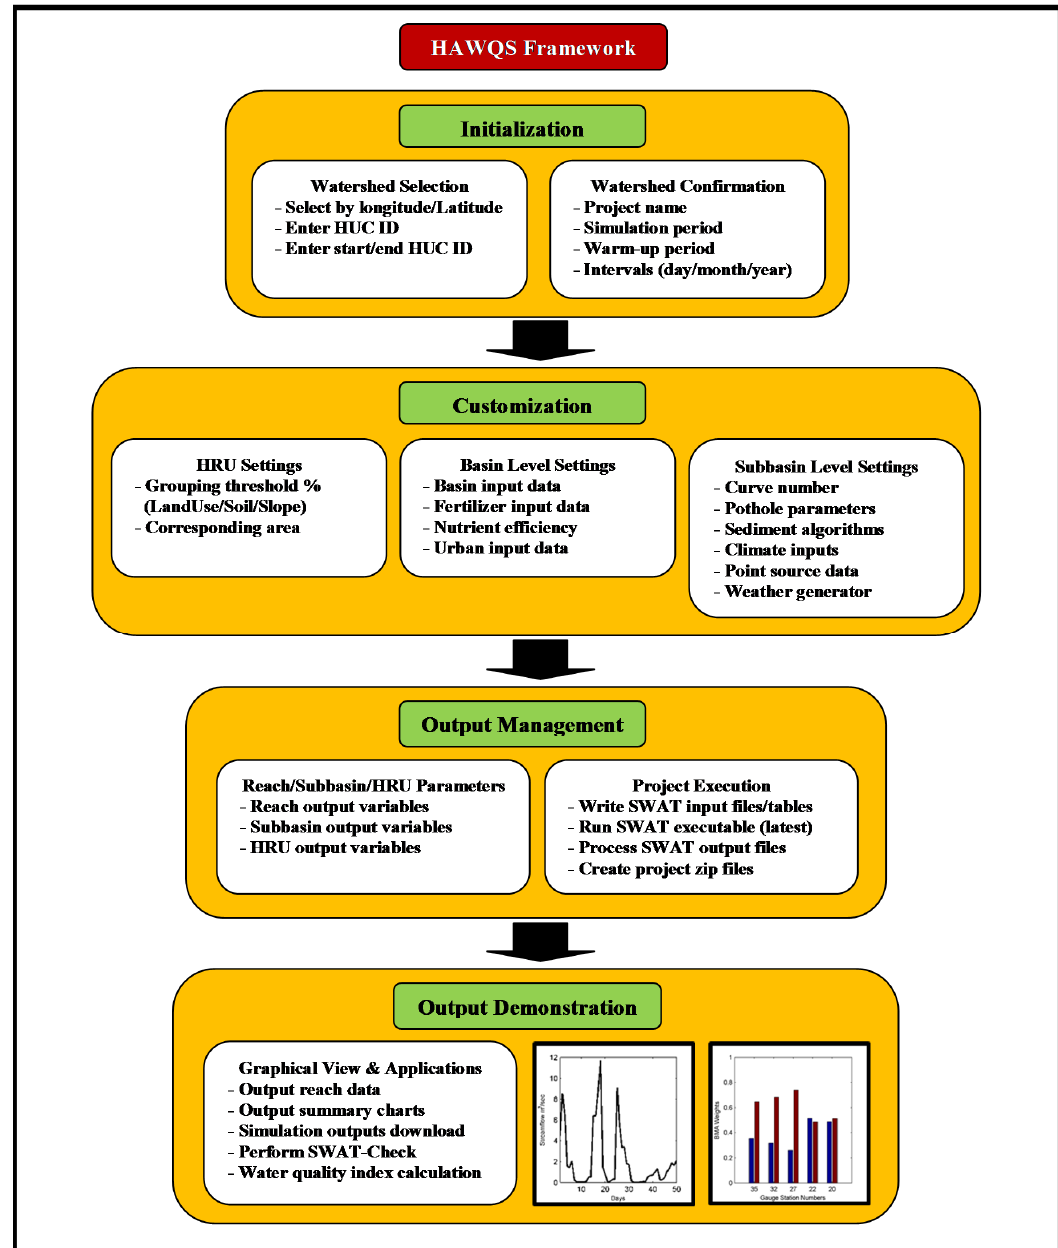
Figure 1. Organogram of the HAWQS operational framework.